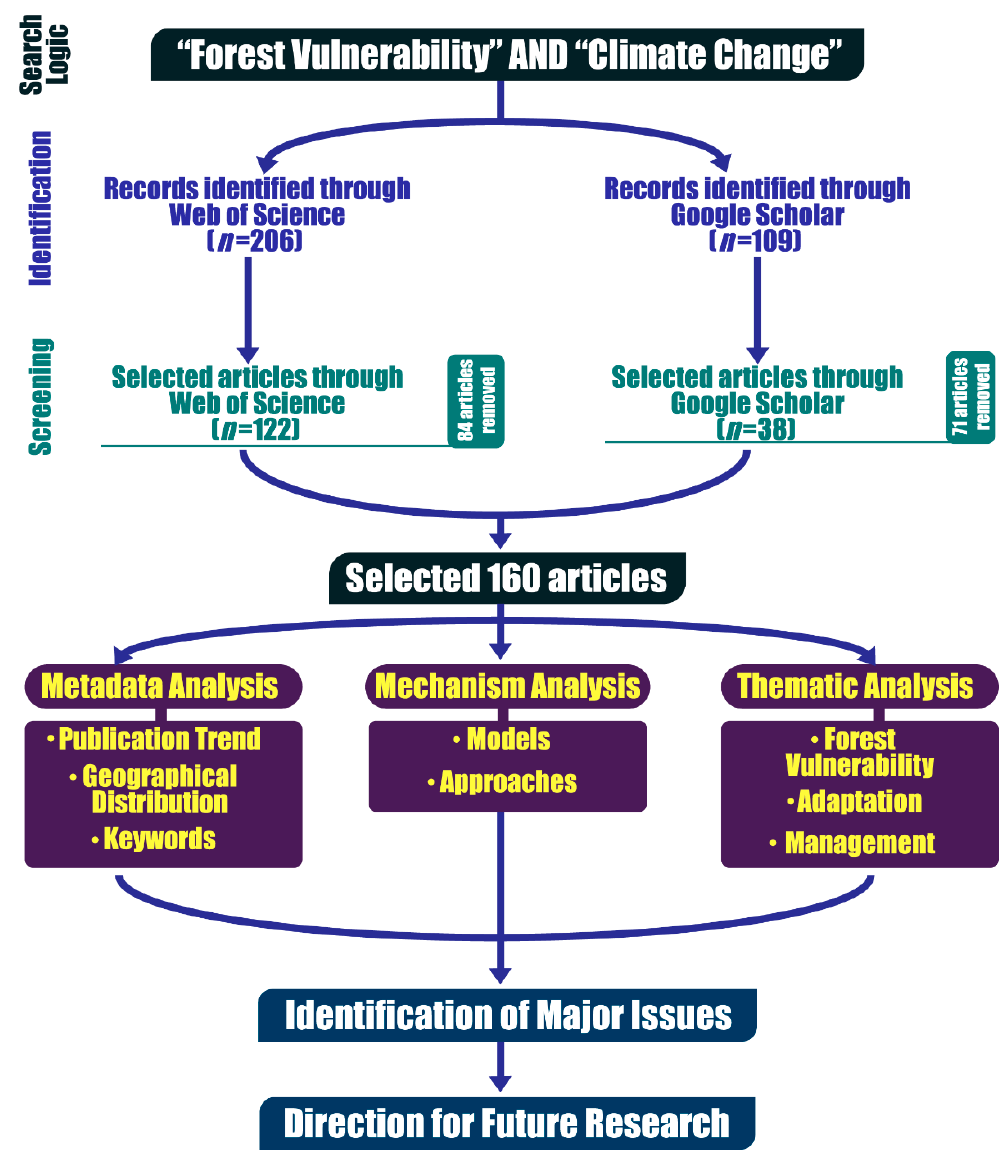
Figure 1. The methodological framework of the systematic review.